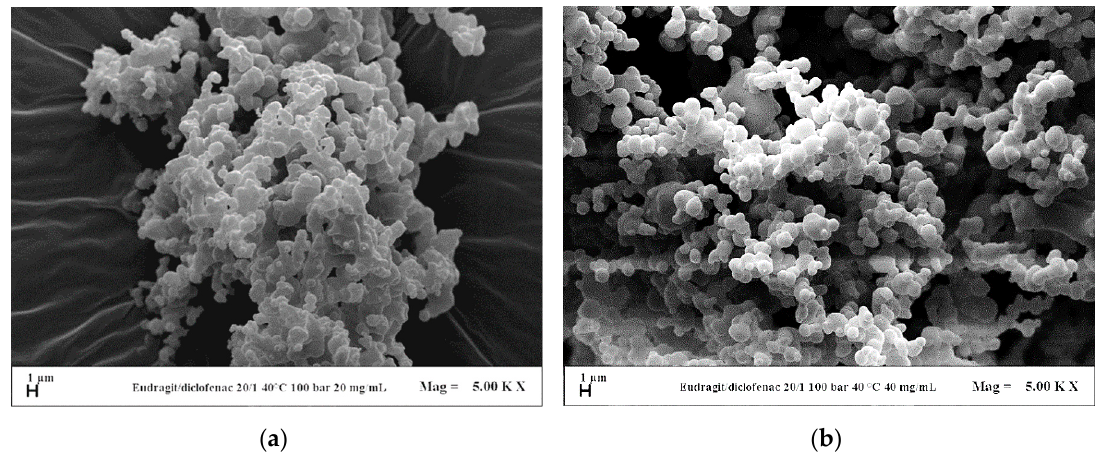
Figure 8. FESEM images of EUD/DICLO 20/1 particles precipitated from DMSO at 40 °C, 10 MPa. ( a ) 20 mg/mL (run #8); ( b ) 50 mg/mL (run #9).